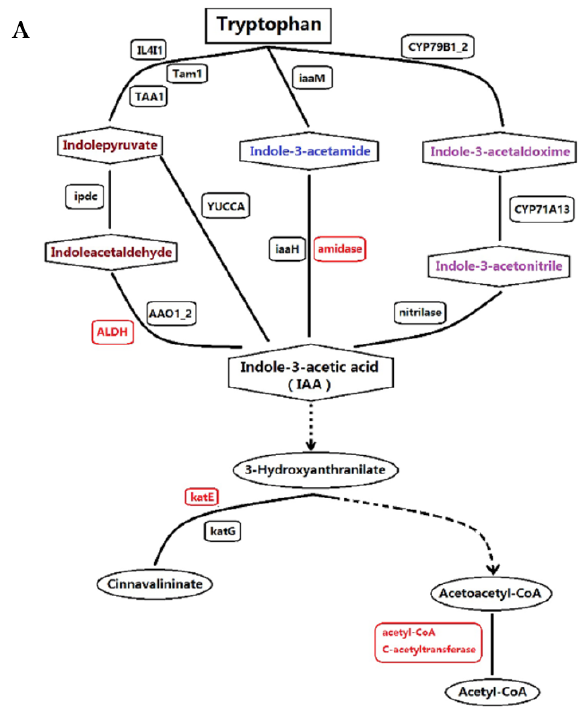
Figure 6. Metabolic analysis of KEGG pathway (matched number more than four) and KEGG Enrichment: ( A ) KEGG Pathway; ( B ) the percentage of Metabolic Pathway; and ( C ) KEGG Enrichment. * and ** indicate significant difference at p < 0.05 and p < 0.01 by Tukey’s test,